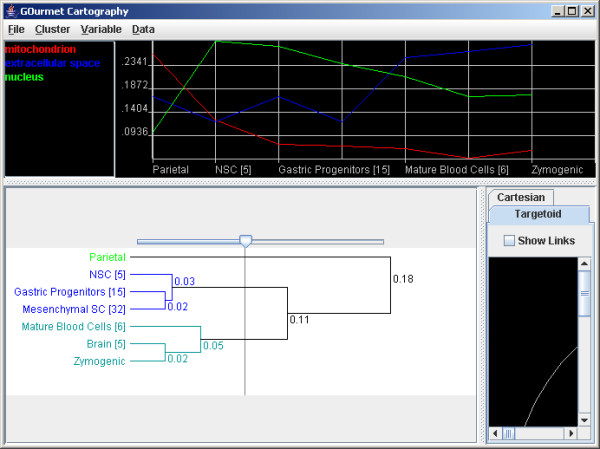
The GOurmet Cartography dendrogram and wave plot windows. Bottom left – the GOCART dendrogram plots all the expression profiles in a hierarchically clustered dendrogram using a modified Pearson's correlation to determine distances between clusters. A sliding bar allows the user to select how sub-clusters are colorized to visualize differences. The dendrogram can be exported as a jpeg. In the example, note how the three sample progenitor expression profiles (MeSC [32], NSC, and GEP) cluster together, and three of the four sample differentiated cell lineage expression profiles cluster together (mature blood, brain, and zymogenic cells [33]). Parietal cells, a highly specialized, differentiated, mitochondria-rich cell type cluster separately, well away from the other lineages. Numbers in brackets indicate reference from which each expression profile was acquired. Top – the GOCART wave diagram allows users to select GO terms (listed at the left of the window) to view their fractional representation among selected expression profiles (profiles to be viewed are selected from the dendrogram plot). Each GO term is automatically assigned a different color in the plot. In the example, note how much higher the fractional representation of the GO term "mitochondrion" (red line) is in parietal cells relative to the other sample expression profiles. The wave diagram can be output as a jpeg image.